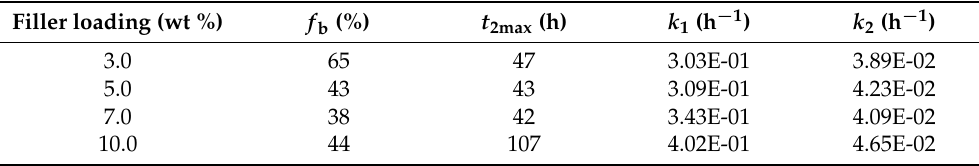
Table 1. Kinetic parameters for the salicylate release derived from Equation (5).